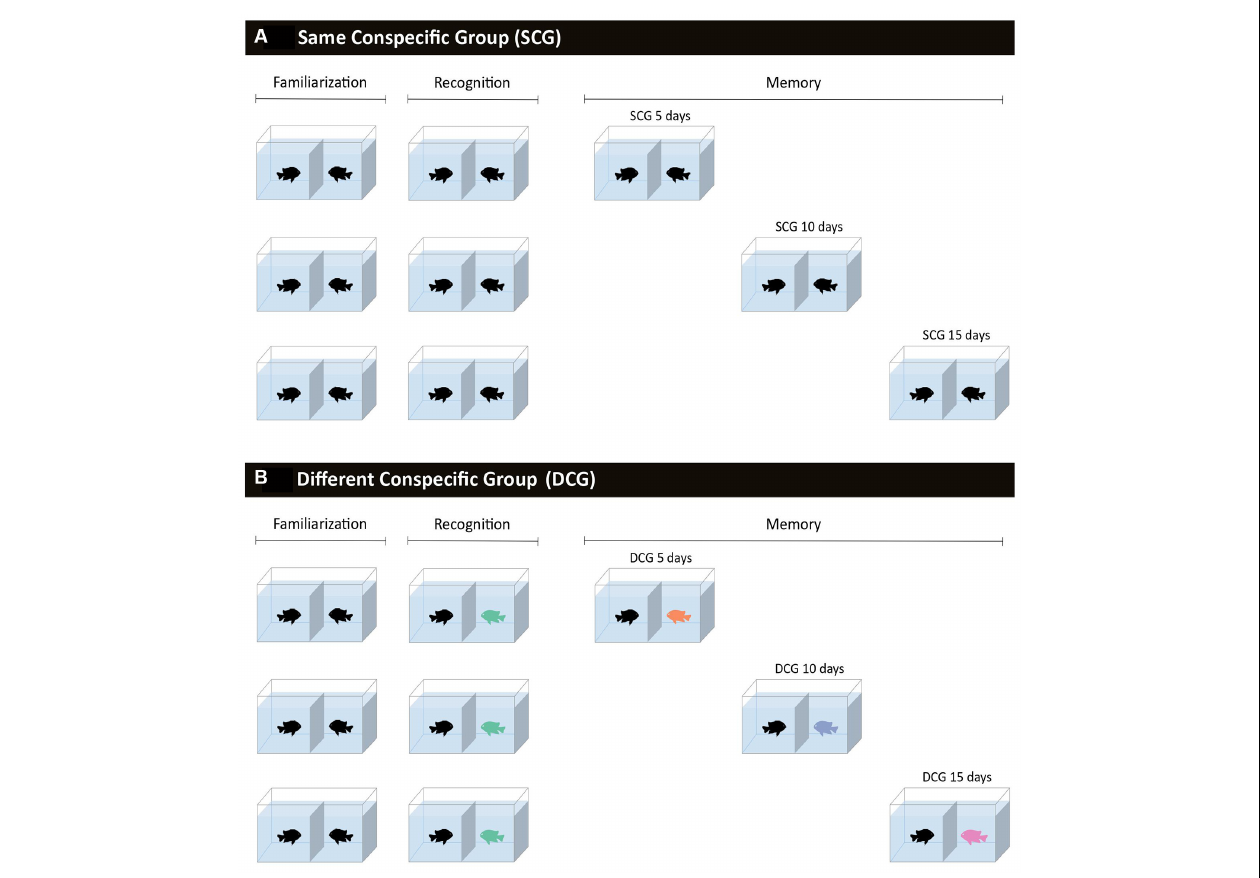
FIGURE 1 | Schematic overview of the experimental procedure. Fish were divided into pairs and separated by a glass wall and a removable partition with gravel wallpaper that permitted visual contact when removed, for 10 min a day. (A) Same conspecific groups, in which fish were paired with the same conspecific during familiarization (5 days), recognition test, and memory tests (5, 10, or 15 days after the recognition test). (B) Different conspecific groups, in which fish were paired with one conspecific during familiarization and the conspecific was replaced by an unfamiliar individual in the recognition test and another in each of the memory tests (5, 10, or 15 days after the recognition